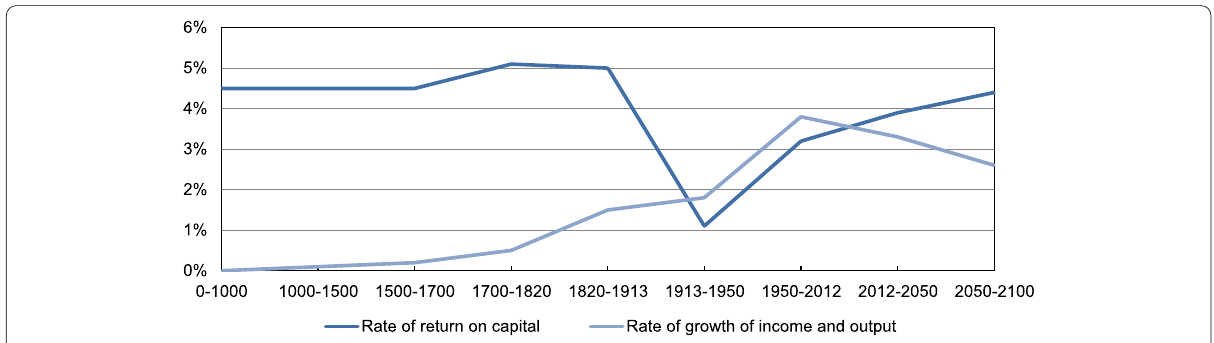
Fig. 4 After-tax rate of return on capital vs. growth rate at the world level, until 2100